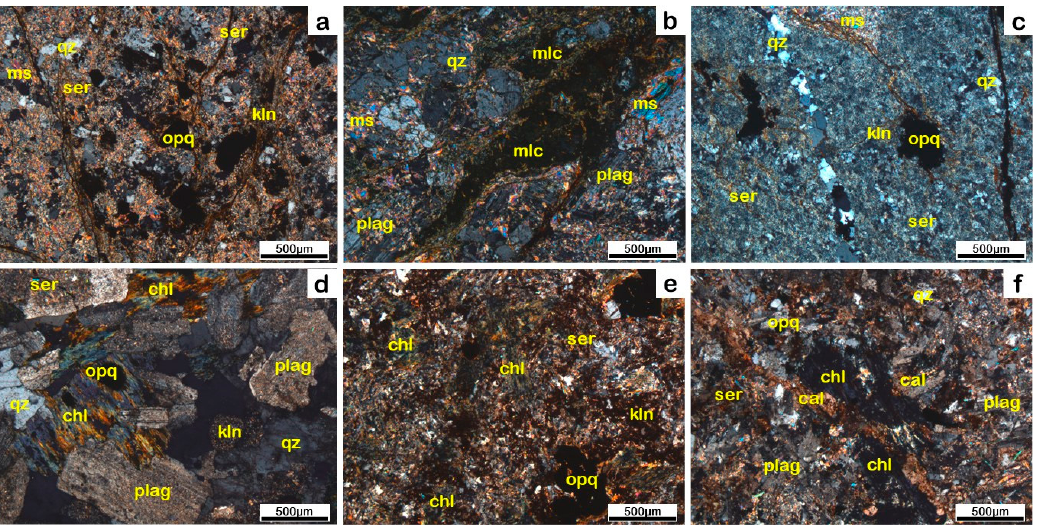
Figure 7. ( a ) Muscovite (sericite), kaolinite, and opaque minerals in alteration zone-1. ( b ) Muscovite (sericite), kaolinite, and malachite in alteration zone-1. ( c ) Kaolinite and sericite with quartz veinlets in alteration zone-1. ( d , e ) Chlorite with subordinate amount of sericite and kaolinite in alteration zone-2. ( f ) Calcite and chlorite minerals in alteration zone-2. Abbreviations: calcite (cal); chlorite (chl); kaolinite (kln); malachite (mlc); muscovite (ms); opaque minerals (opq); plagioclase (plag); quartz (qz); and sericite (ser).